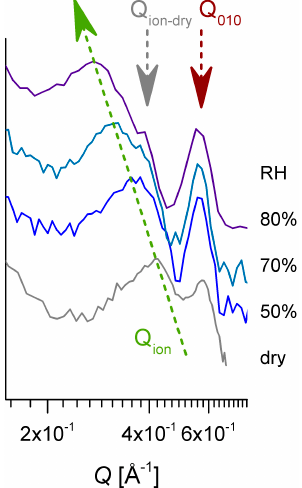
Figure 7. The high-Q range of the SANS patterns on the equatorial direction reported in Figure 6. The pattern from the membrane in a dry state was added. The green arrow indicates the variation in the position of the ionomer peak in increasing the hydration, and the dark red arrow marks the 010 reflection, while the gray arrow points to the ionomer peak position characteristic of the membrane in a dry state.